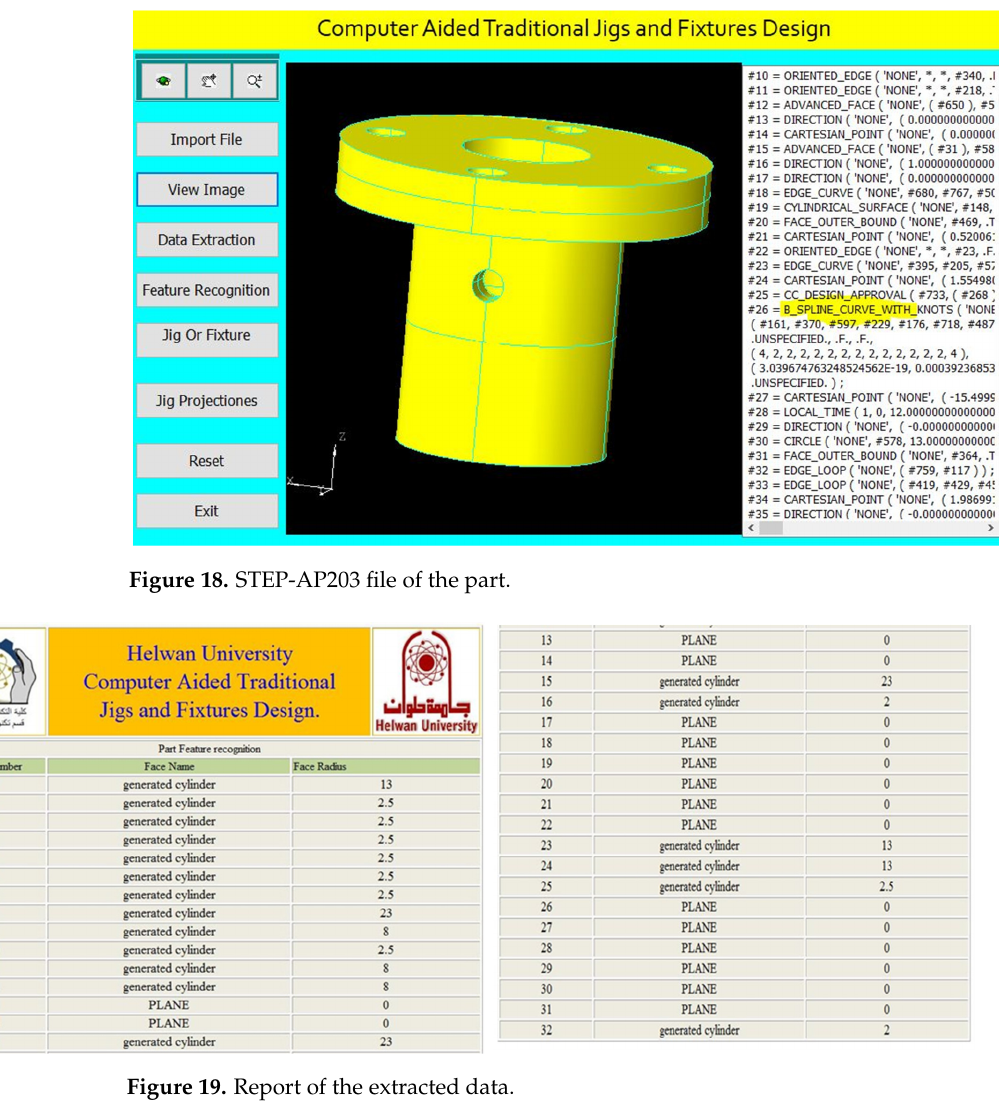
Figure 19. Report of the extracted data.